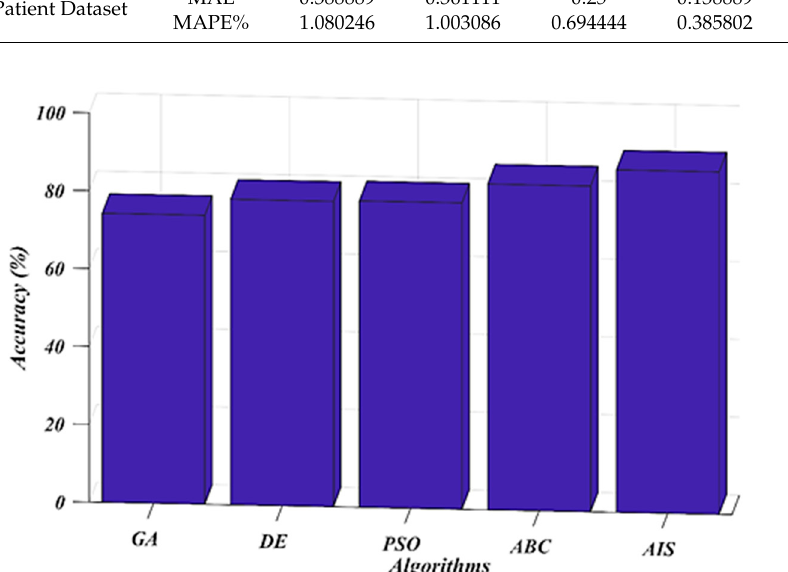
Figure 8. Accuracy Evaluation for German Credit.